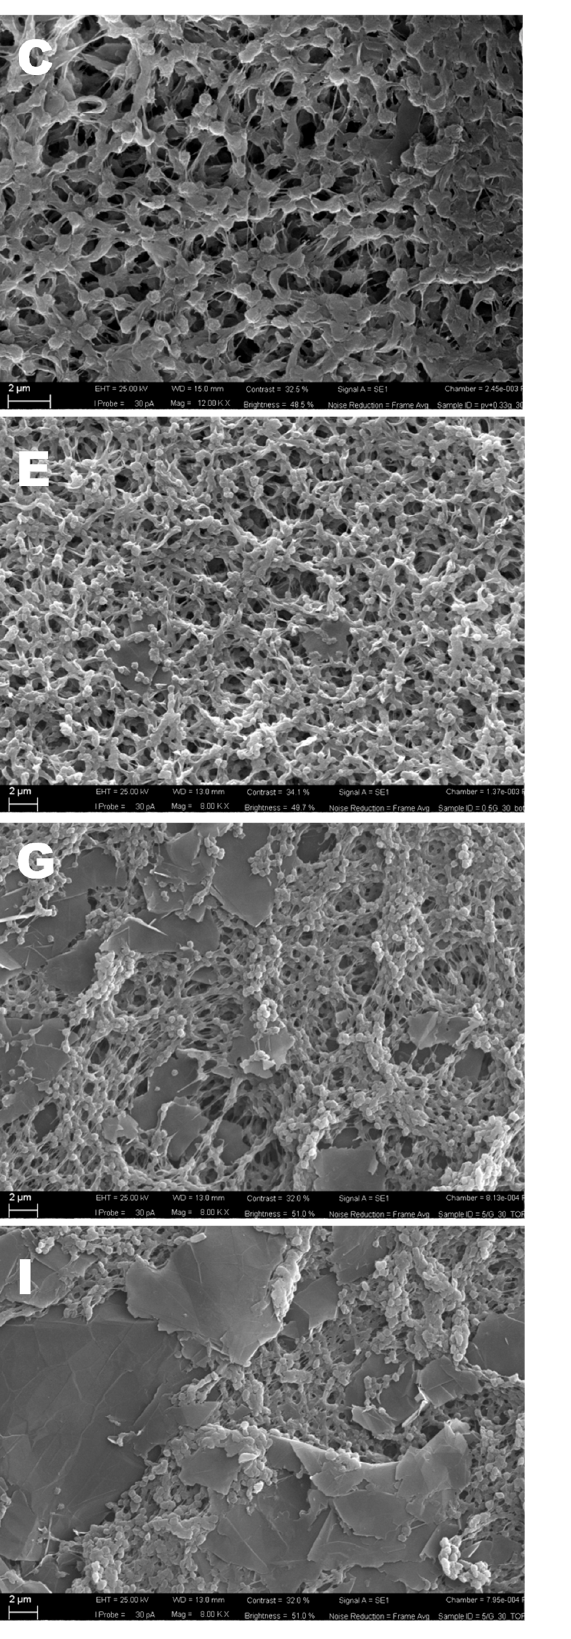
Figure 1. Top view SEM images (the scale bars in the images are 2 µ m) and AFM 3D images (5 × 5 µ m) of all the membranes: ( A , B ) pristine PVDF, ( C , D ) PVDF_0.33G, ( E , F ) PVDF_0.5G, ( G , H ) PVDF_5G, and ( I , J )